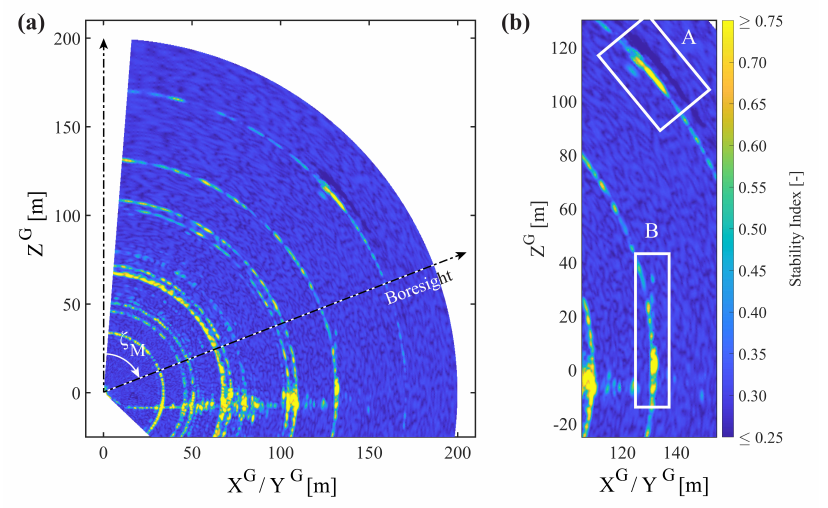
Figure 8. Example of stability indices for a time series of MIMO-SAR acquisitions over a period of 30s with ( a ) showing the same section as in Figure 4 and ( b ) being a detailed view of the wind turbine where the turbine and top of the tower are outlined with a box A, and the lower third of the tower is outlined with a box